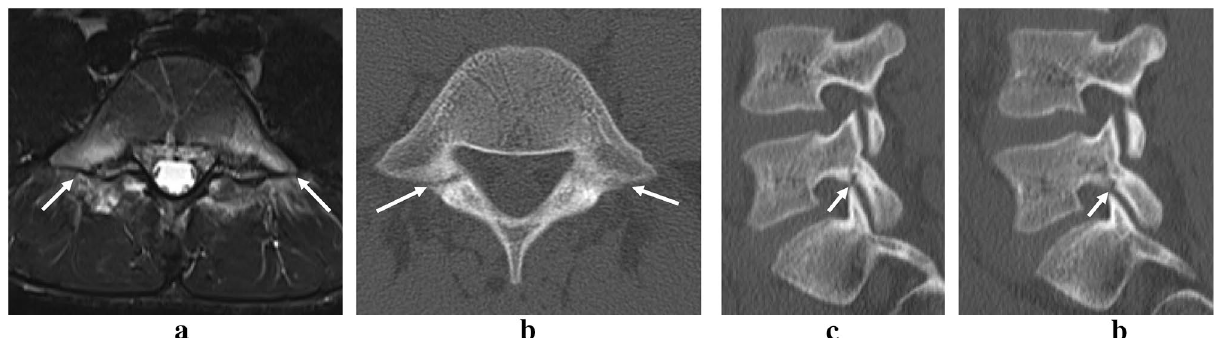
Figure 1. The short tau inversion recovery magnetic resonance images (STIR-MRI) at the first examination showed high intensity change bilaterally (white arrows) in the pedicles of L5 ( a ). CT revealed bilateral faint fracture lines (white arrows) on the axial slice ( b ) and slight bone resorption (white arrows) on the ventral side of the lamina in the sagittal view ( c , d